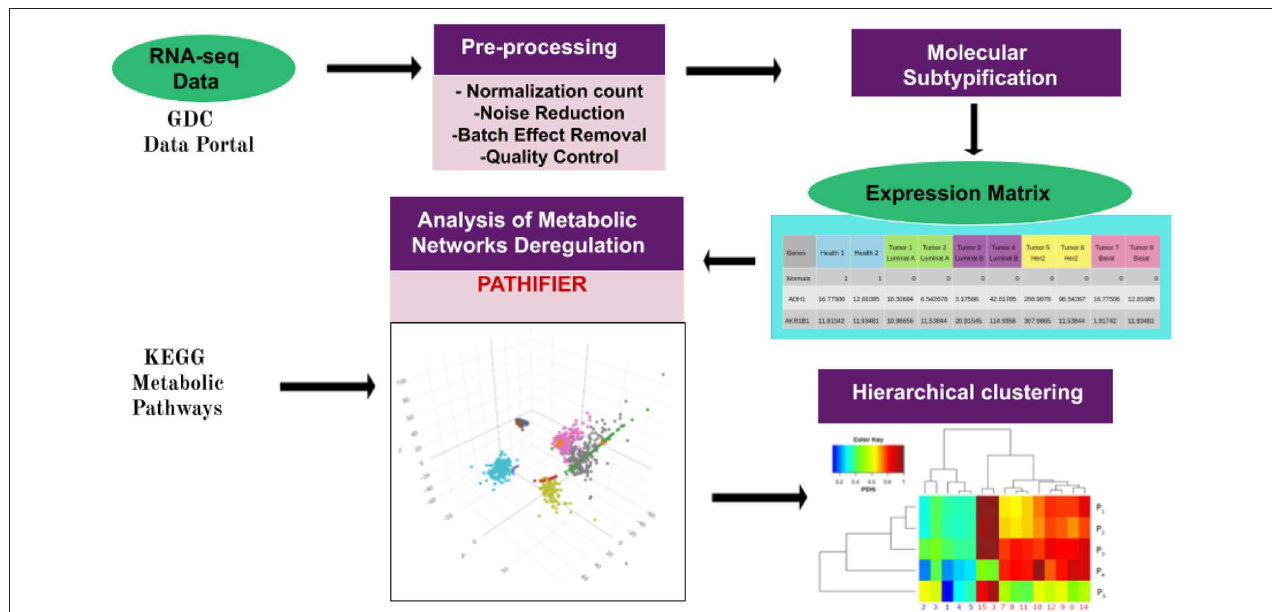
FIGURE 1 | Pipeline of the work presented here. The workflow starts with data acquisition from the TCGA Genome Data Commons Data Portal. Pre-processing of gene-expression files was performed as in Espinal-Enríquez et al. ( 21). Breast cancer molecular classification was made by using the pcbcmc R package (12). Molecular subtype classification of normalized samples provides us with a gene-expression matrix, which is used to run the Pathifier algorithm (19). This algorithm assigns a Pathway Deregulation Score (PDS) to every metabolic pathway in each sample. The PDS is a score between 0 and 1. Here, 0 corresponds to the centroid of the control samples of a given pathway. The score increases according to the distance of the sample from this centroid along a principal curve, spanning the cloud of data points. The pathways used to perform Pathifier were obtained by filtering the metabolism-associated KEGG pathways. Finally, PDSs were grouped by using unsupervised hierarchical clustering. Hierarchical clustering modified from García-Campos et al. ( 30).